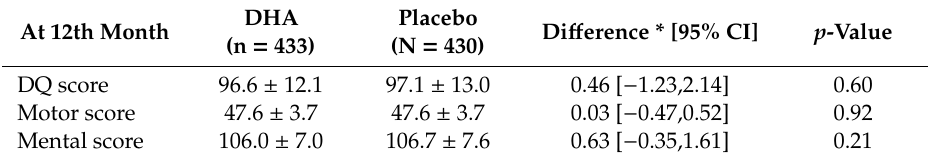
Table 5. DQ score and components of DQ (motor and mental scores) at 12th month. At 12th